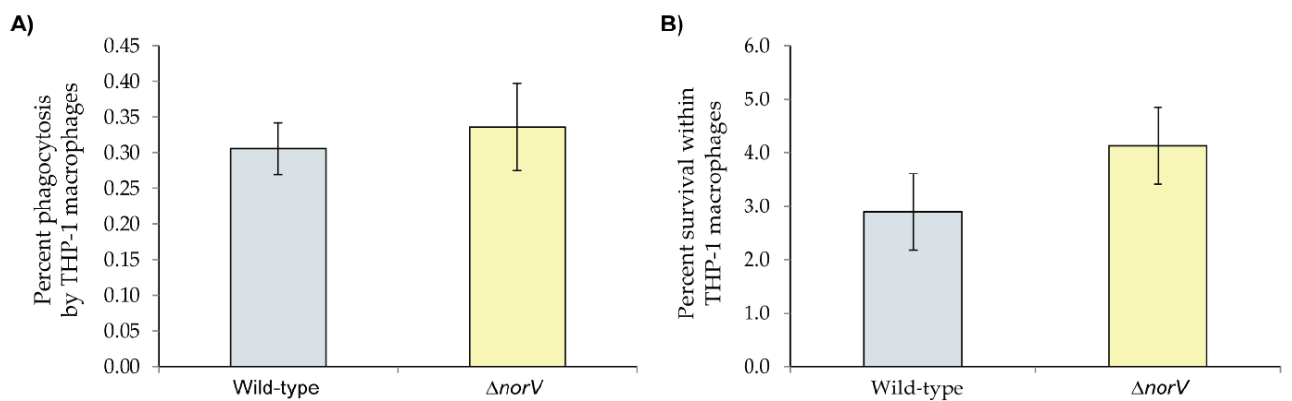
Figure 4. ( A ) Phagocytic uptake and ( B ) intracellular survival of the E. coli O157:H7 wild-type (WT) TW14359 outbreak strain relative to the isogenic ∆ norV strain in THP-1 macrophages. Uptake was examined 1 h post-infection and survival was determined after 24 h. Boxes represent the means of three independent replicates and the bars show the standard deviation of the means. No significant differences were observed between strains for either phagocytic uptake or intracellular survival using a Student’s t -test.